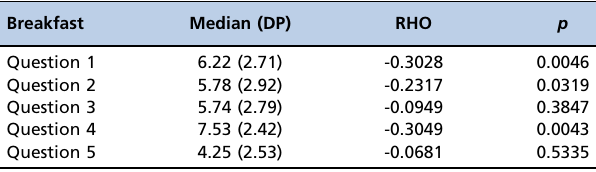
Table 3 - Correlation between EAA-BR scores and rest-ingestion index of